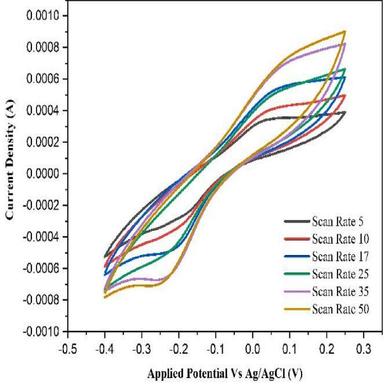
Cyclic Voltammetry (CV) curves of cotton electrodes in the potential range of – 0.5–0.3, scan rate of 5,10, 17, 25,35, 50 mV s -1.